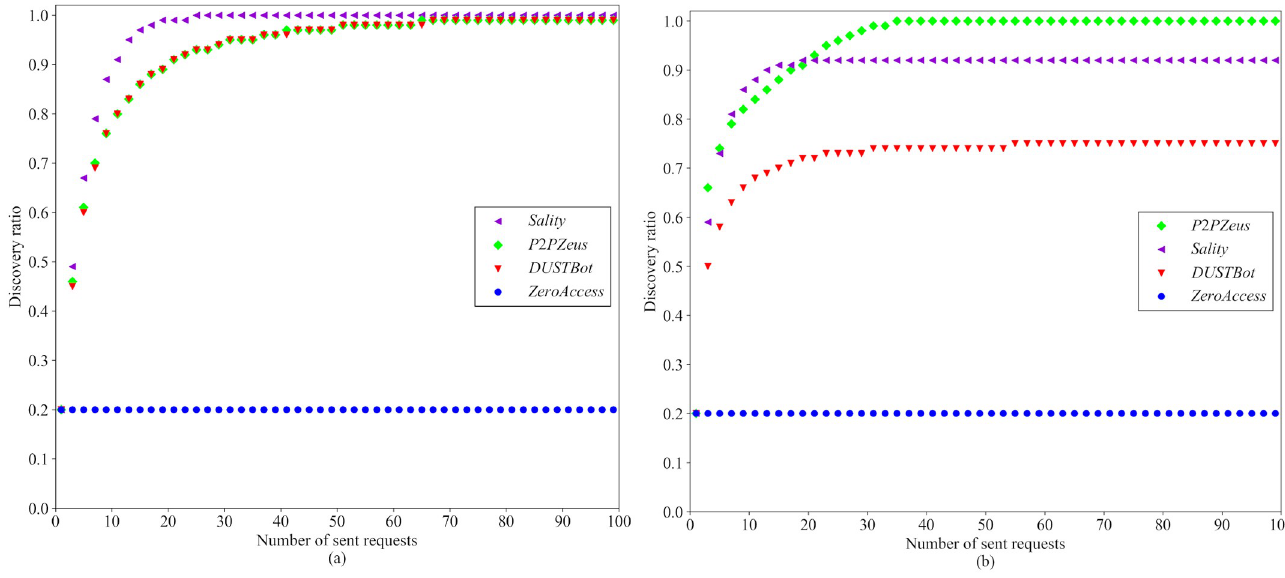
Fig 11. Performance of Random (a) and ZeusMilker (b) on different anti-crawling strategies ( S